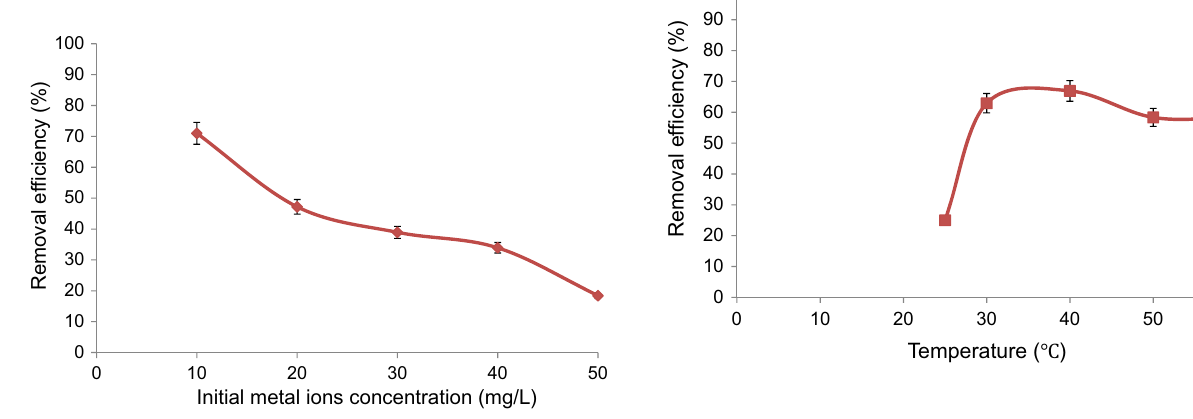
Fig. 3 Effect of initial concentration on the adsorption of Cd(II) ion onto UMSFS biomass